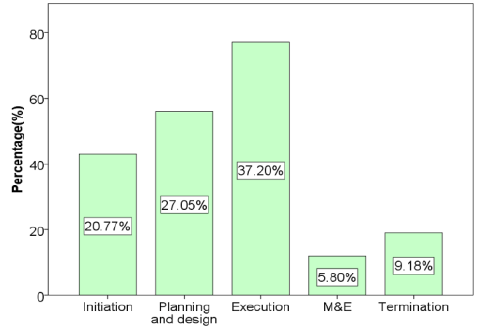
Figure 2: Agroforestry Phases included in Organization’s Policy